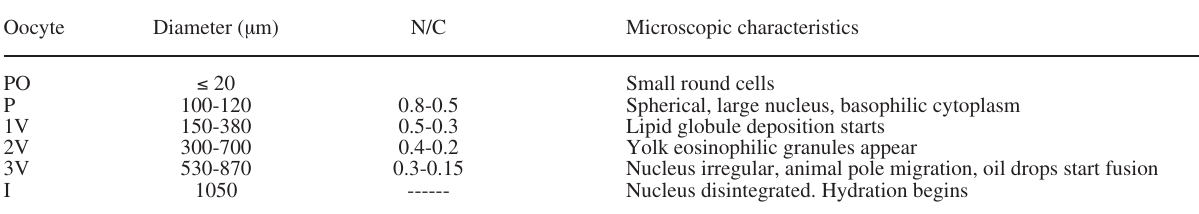
Table 2. – Oocyte development in European hake of the Mediterranean following the description of Sarano (1986) and Murua et al. (1998, 2006). PO, Primary oocytes, -primary growth; P, previtellogenic; 1V, 1 st vitellogenic stage (cortical alveoli stage); 2V, 2 nd vitellogenic stage; 3V, 3 rd vitellogenic, migration stage; I, hydration stage. N/C, nucleus/cytoplasm